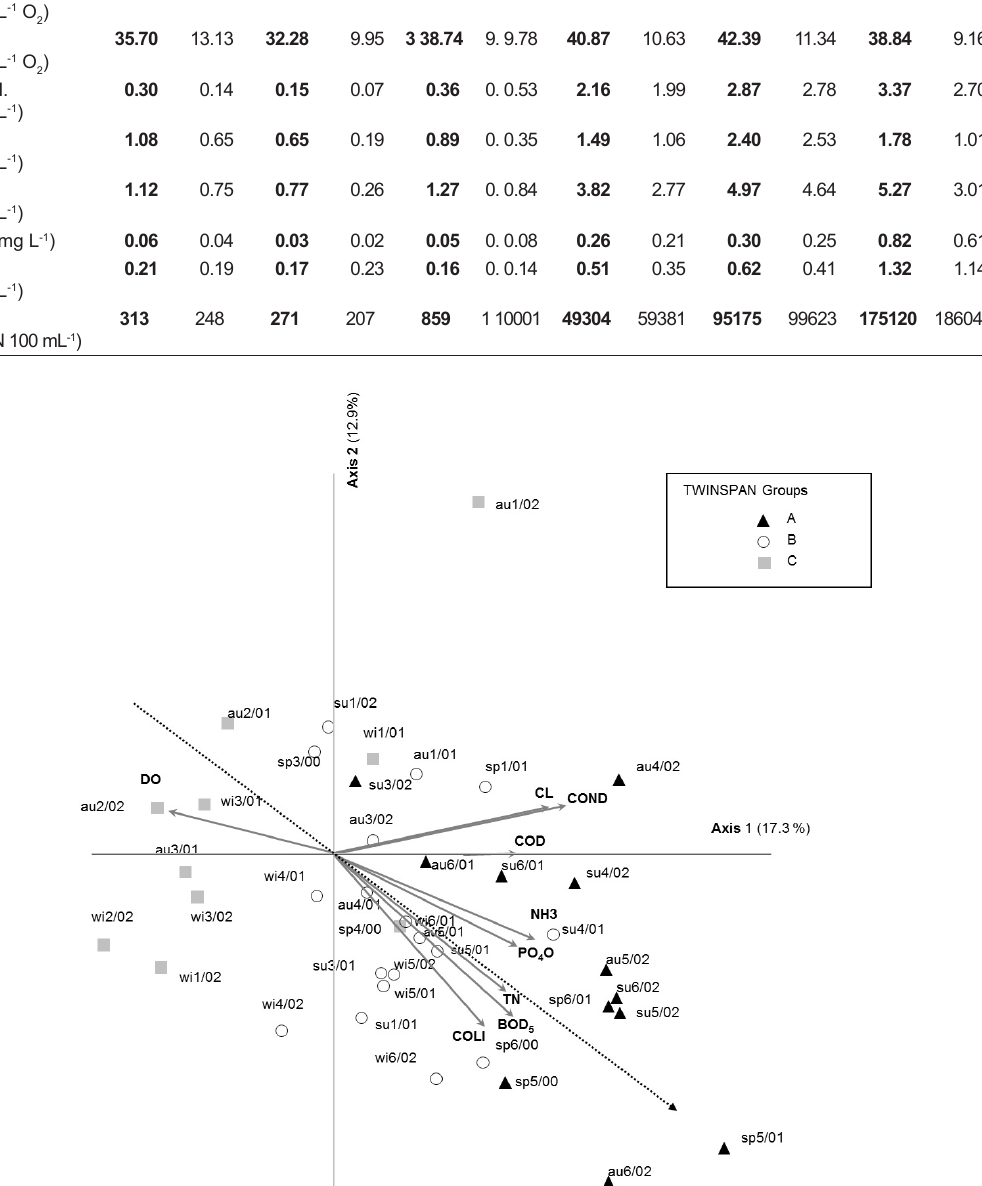
Figure 4. CCA biplot showing the ordination of 40 sampling sites based on TWINSPAN groups of diatom species composition (Salomoni et al., 2006). CL = chlorides; COLI = thermotolerant coliforms; COND = conductivity; BOD = biochemical oxygen demand after five days; COD = chemical oxygen demand; NH 5 O = orthophosphate. Dashed arrow indicates pollution nitrogen; DO = dissolved oxygen; PO 4